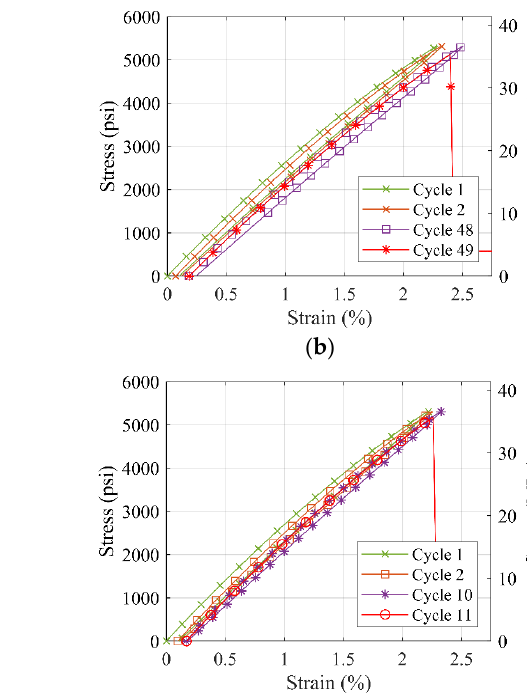
for sample 1 ( b ) 90% of the max load for sample 1 ( c ) 70% of the max load for sample 2 ( d ) 90% of the max load for sample 2.